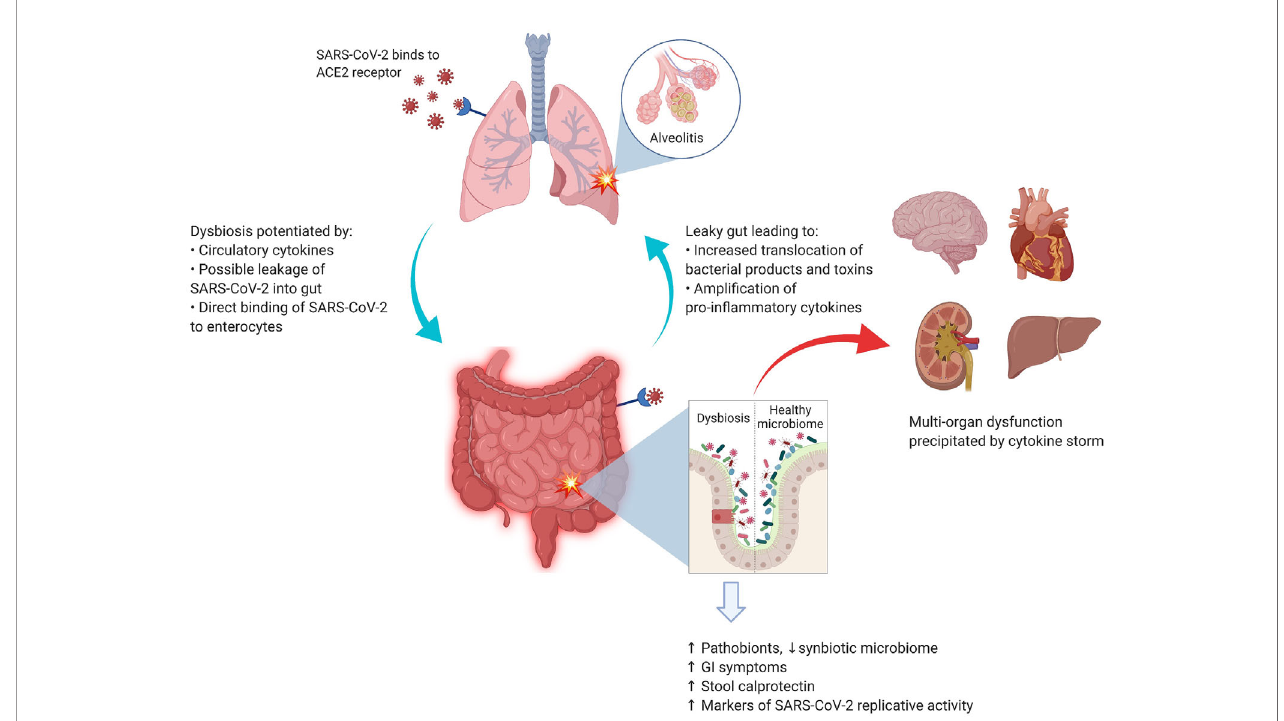
FIGURE 1 | SARS-CoV-2 and the lung – gut axis: SARS-CoV-2 virus enters the alveolar cells by binding with ACE2 receptors, which are also abundant on the surface of enterocytes. The implication of direct infection of enterocytes by SARS-CoV-2 is still being explored. The circulatory cytokines from alveolitis (and/or direct viral infection of the enterocytes) cause the GI dysbiosis with resultant alterations in GI mucosal barrier. The entry of bacterial products and toxins from the GIT fl oods the circulatory system with more pro-in fl ammatory cytokines. Image was created with